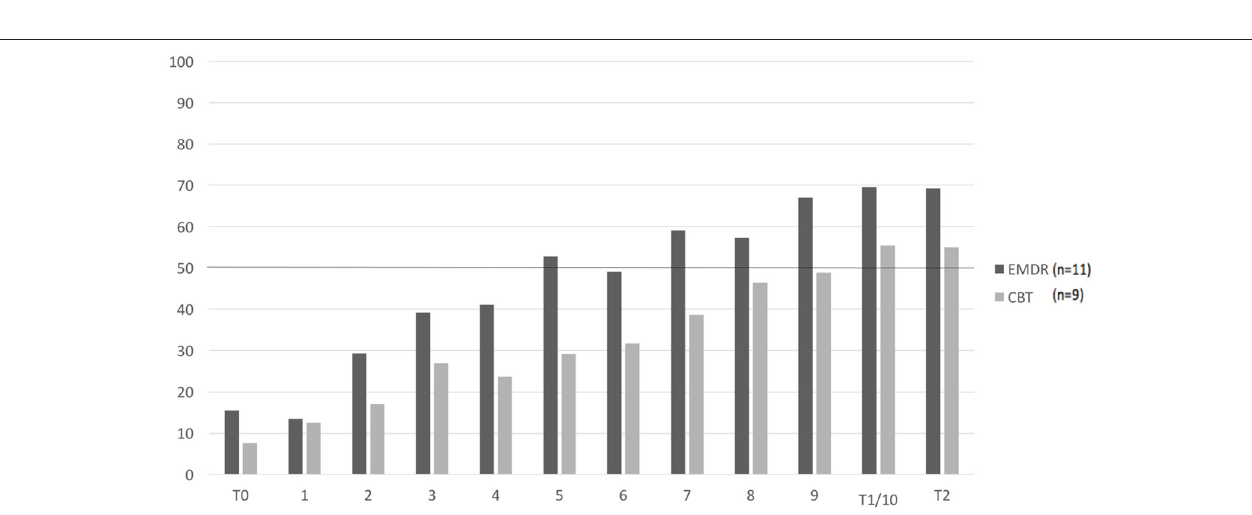
20). CPAB, Credibility of Positive Alternative Belief. T0: pre-treatment, T1: =